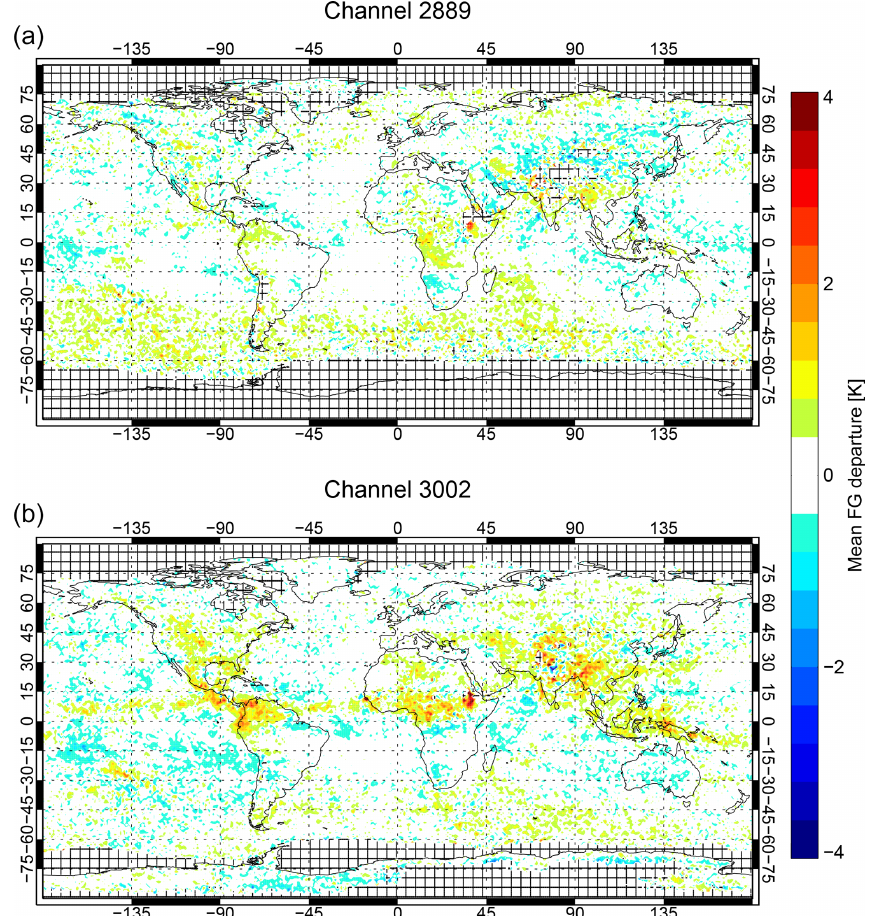
Figure 8. Mean clear-sky background departures in channels 2889 and 3002 (using operational bias correction) sampled over 1–20 June 2017. The sample is composed only of actively assimilated observations from Metop-A. Table 3. Summary of